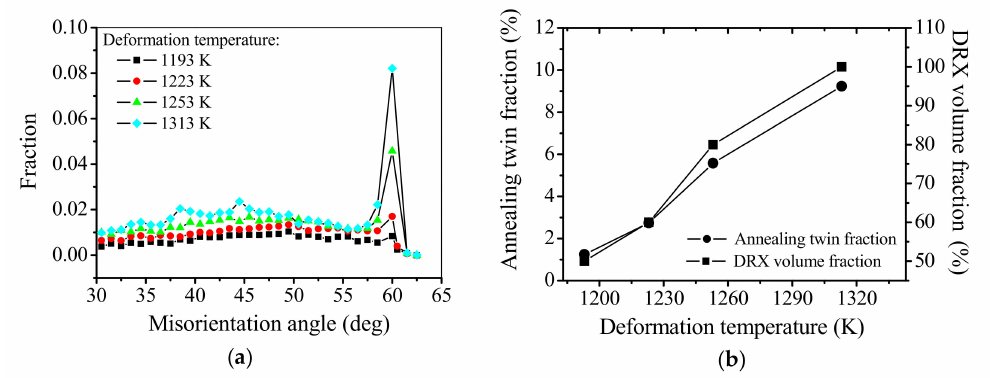
Figure 7. Changes of annealing twin fraction and DRX volume fraction at the strain and strain rate are 1.2 and 0.01 s − 1 , respectively. ( a ) misorientation angle distribution, and ( b ) variations of annealing twin fraction and DRX volume fraction with deformation temperature.